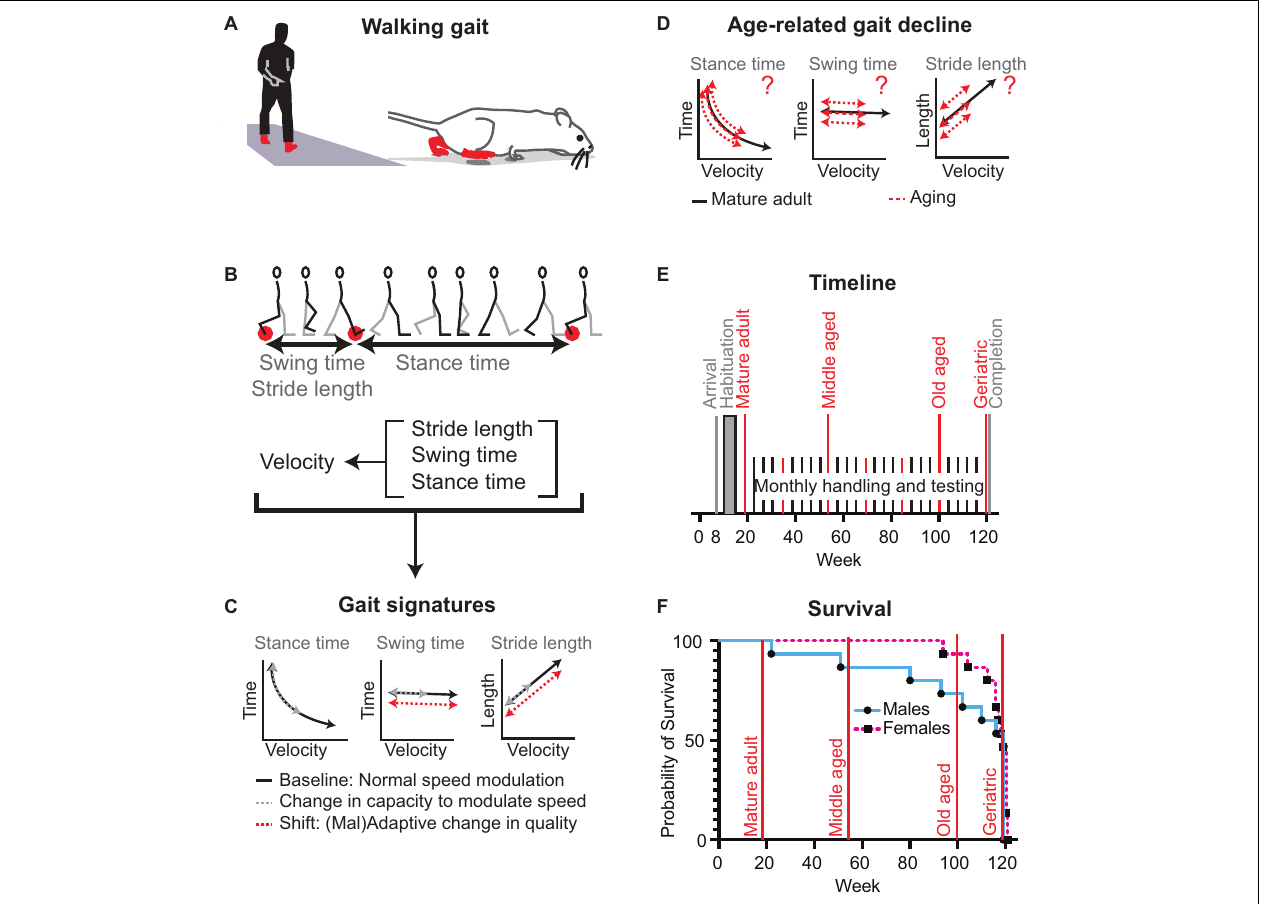
FIGURE 1 | Definition of gait signatures and study design to distinguish age-related changes in walking speed from changes in walking phenomenology. (A) Walking represents a slow gait pattern that is shared between biped and quadruped models. (B) Determinants of walking velocity are the spatial metric stride length and the temporal metrics stance time and swing time. These three metrics change as a function of stride velocity, but do so in a distinct manner, each forming a distinctive signature among species (Broom et al., 2017, 2019). (C) During normal speed modulation (solid black lines) or a reduction in capacity to modulate speed (gray dashed lines), gait metrics abide the rules of these signatures. In the setting of adaptive or maladaptive changes in the nervous system, sets of gait signatures may shift [red dashed lines, example represents parkinsonism in human and mouse models (Broom et al., 2017, 2019)]. (D) It is not known whether age-related decline in gait speed involves changes capacity and/or walking style, what the timing and nature is of these changes, and whether they are the same for both sexes. (E) Timeline of the longitudinal study: Female ( N = 15) and male ( N = 15) cohorts of C57BL/6J mice entered the study simultaneously. We analyzed mobility and gait data at key time points (red lines) representing mature adult (19 weeks), middle aged (55 weeks), old aged (99 weeks), and oldest aged (119/120 weeks). (F) Survival curves of the female and male cohorts in relation to key time